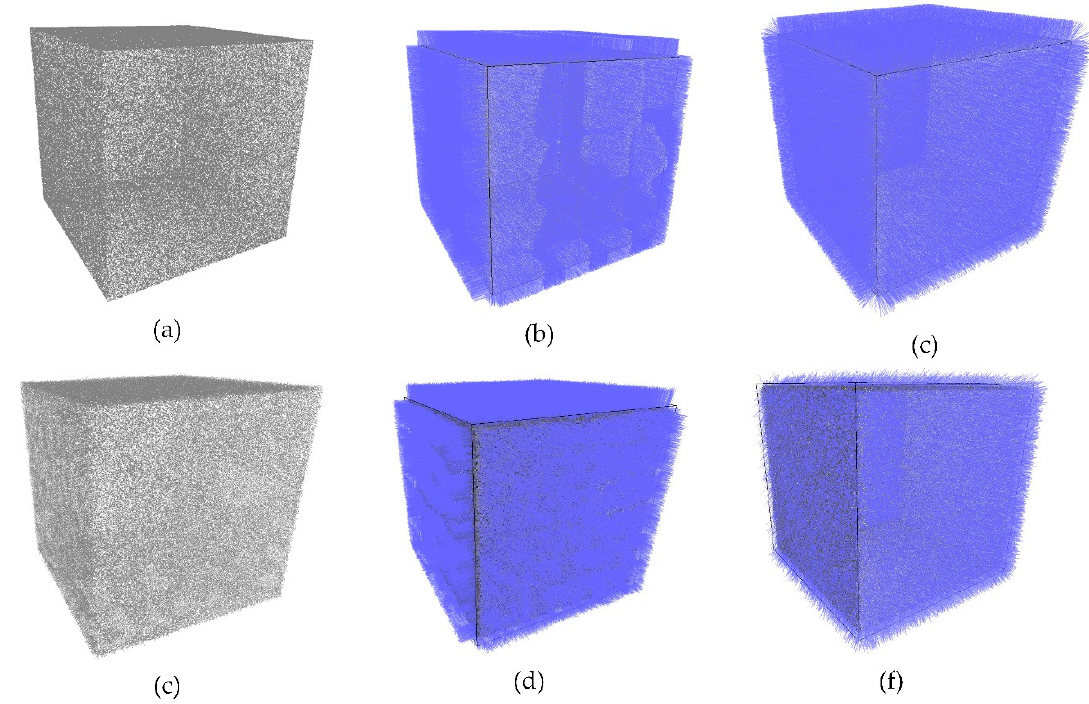
Figure 6. Visualization of normal vectors. ( a ) shows a cube model with 240,000 points. ( c ) shows the same model but with 0.5% noise. ( b , d ) show the results from the proposed method, the RMSE are 0.0022 and 0.0231 respectively. ( c , f ) show the results estimated by local information only, the RMSE are 0.0707 and 0.433 respectively. The proposed method produces more consistent normal vectors.